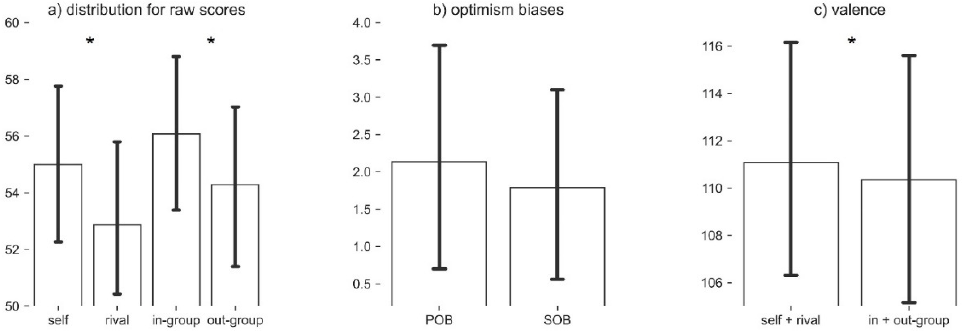
Figure 2. Behavioral data. Behavioral data for the raw scores ( a ) and the derived measures ( b ) are presented. * Indicates a significant difference in the means ( p < 0.05). Derived measures are POB = self-rival, and SOB = in-group–out-group, where POB stands for personal optimism bias and SOB for social optimism bias. The differences for positive versus negative valence are also shown ( c ).